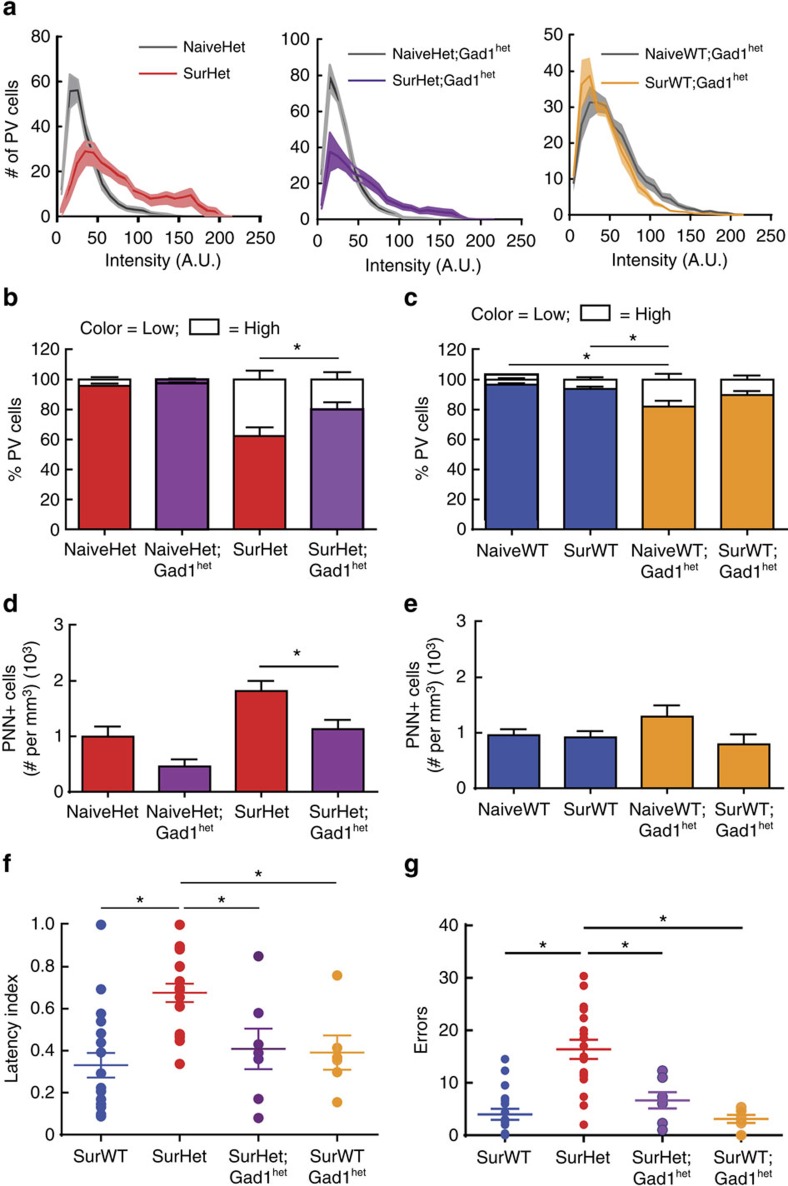
Genetic manipulation of the GABA synthesizing enzyme Gad1 rescues cellular and behavioural phenotypes in Mecp2het.(a) Histograms showing the mean distribution of PV cell intensity comparing SurHet (left, red), SurHet;Gad1het (middle, purple) and SurWT;Gad1het (right, orange) at D5 to their respective naive genotypes (grey). SurHet;Gad1het showed a smaller shift toward elevated PV expression after maternal experience (n=4353–5079 PV+ cells, 16–20 images, 4–5 mice). The solid line and shaded region represent mean±s.e.m., respectively. (b) SurHet;Gad1het showed a significant decrease in the high-intensity PV population compared with SurHet at D5 (ANOVA: Tukey's post-hoc test, *P=0.02). (c) NaiveWT;Gad1het showed significantly more high-intensity PV cells compared with NaiveWT and SurWT. Upon maternal experience, the PV population of SurWT;Gad1het shifted towards WT PV expression levels (n=3561–4782 PV+ cells, 16–20 images, 4–5 mice; ANOVA: Tukey's post-hoc test, *P<0.05). (d) At D5, high-intensity PNN densities were significantly reduced in SurHet;Gad1het, compared with SurHet (n=196–1735 PNN+ cells, 17–38 images, 4–9 mice; ANOVA: Tukey's post-hoc test, *P=0.01). (e) High-intensity PNN densities were not significantly different between WT; Gad1het and WT mice, before and 5 days after maternal experience (n=319–780 PNN+ cells, 16–28 images, 4–7 mice; ANOVA: Tukey's post-hoc test, P>0.05). (b–e) Bar graphs represent mean±s.e.m. (f,g) Pup retrieval behaviour is significantly improved in SurHet; Gad1het (purple) (N=7 mice) as measured by normalized latency (f) and errors (g) averaged across three sessions (SurWT: N=18 mice; SurHet: N=18 mice; SurWT; Gad1het: N=7 mice. ANOVA: Tukey's post-hoc test, *P<0.05). Mean±s.e.m. are shown.